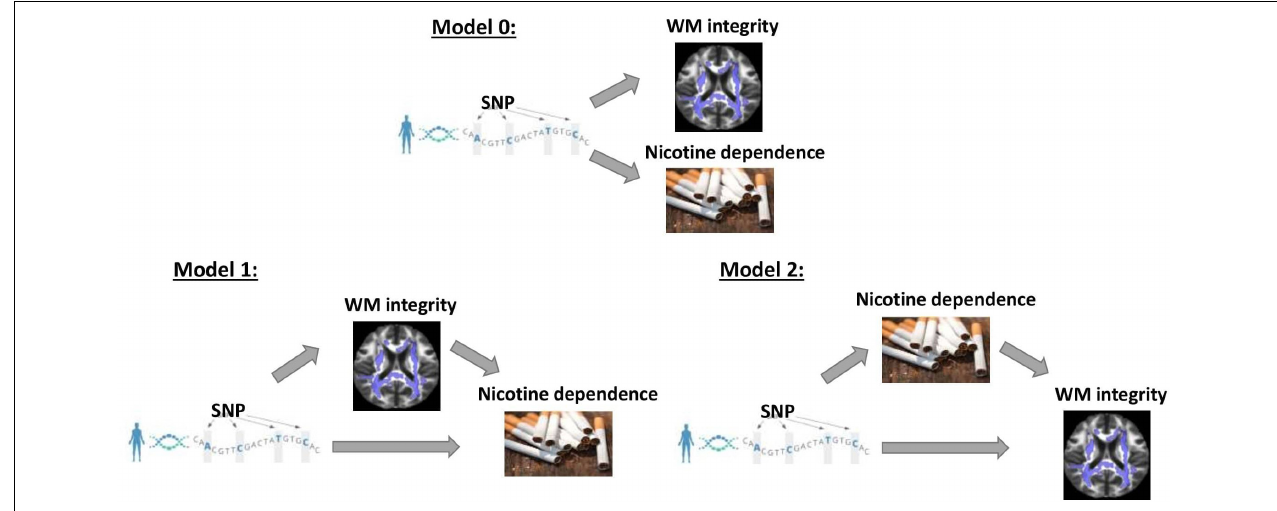
FIGURE 1 | Three competing vertical and horizontal pleiotropy pathways proposed to understand the causal relationship between genetics, white matter integrity, and nicotine dependence. Model 0 represents a horizontal pleiotropic relationship, while models 1 and 2 represent vertical pleiotropic relationships.